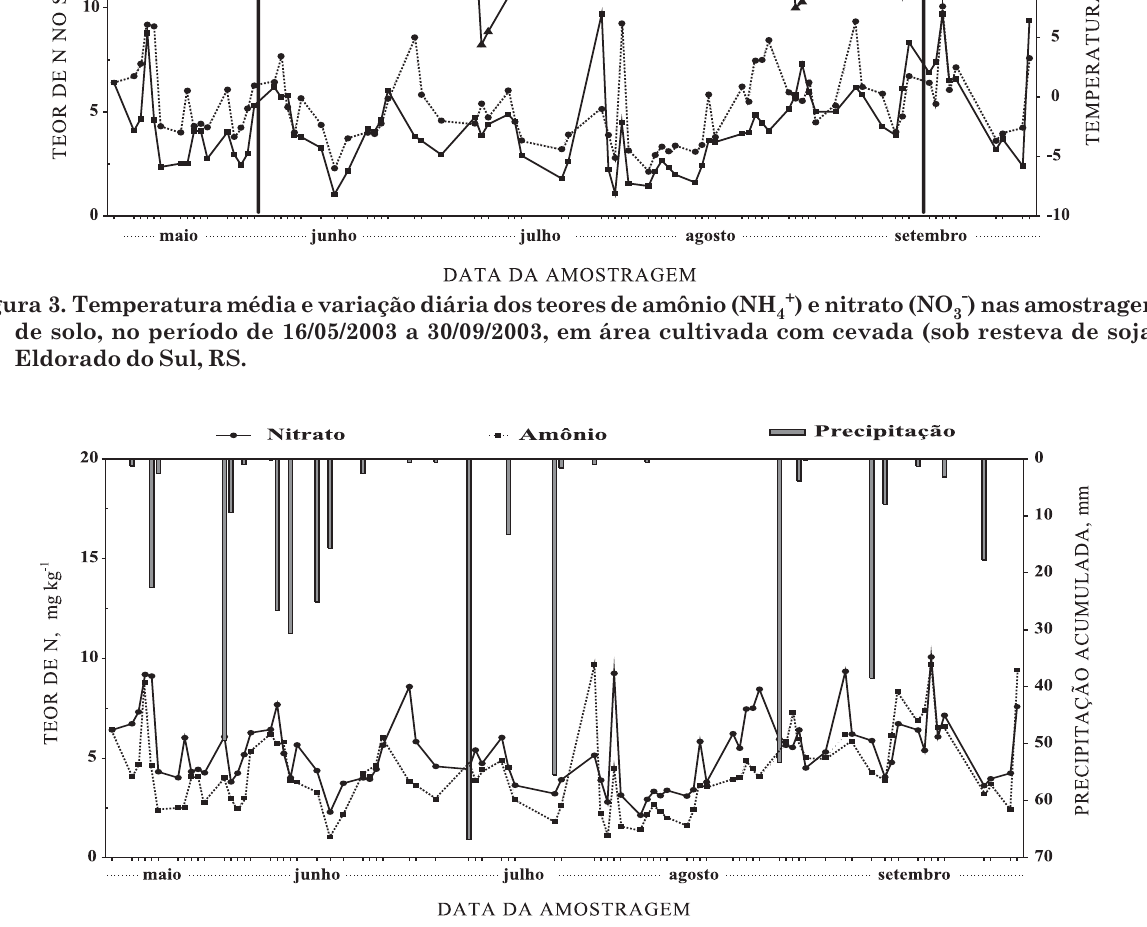
Figura 4. Precipitação acumulada e variação diária dos teores de amônio (NH 4+ ) e nitrato (NO amostragens de solo, no período de 16/05/2003 a 30/09/2003, em área cultivada com cevada (sob resteva de soja), Eldorado do Sul-RS.